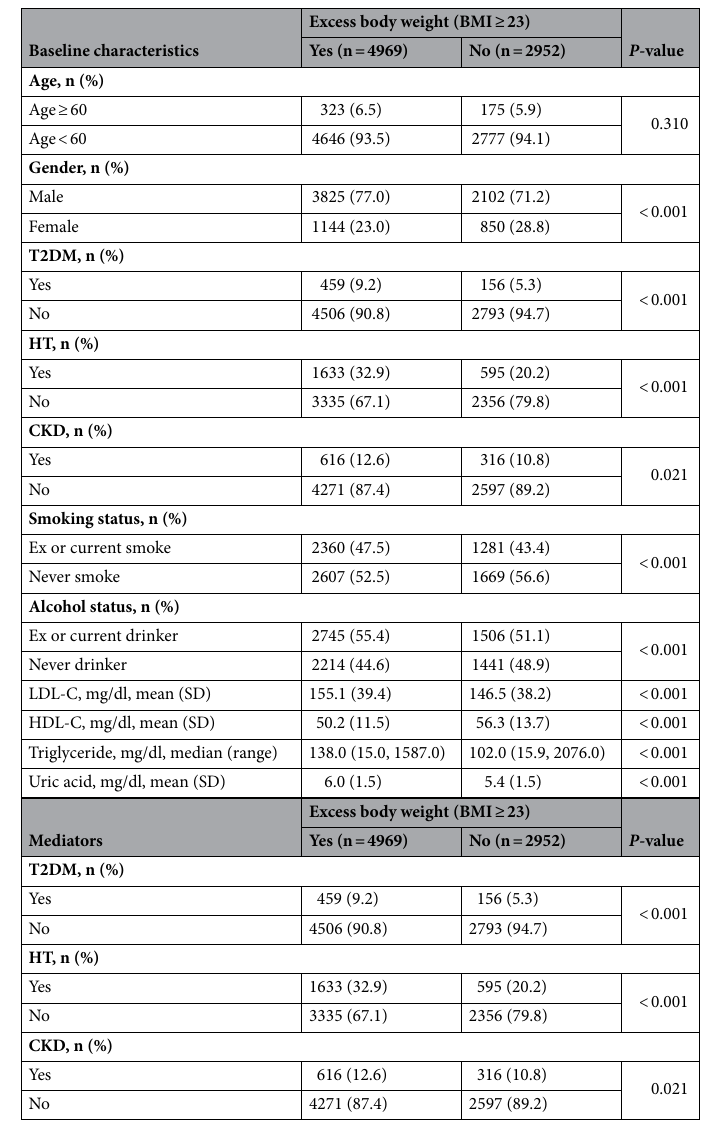
Table 1. Characteristics of the study population at baseline, grouped as with and without excess body weight. BMI body mass index, CKD chronic kidney disease, CVEs cardiovascular events, HDL-C